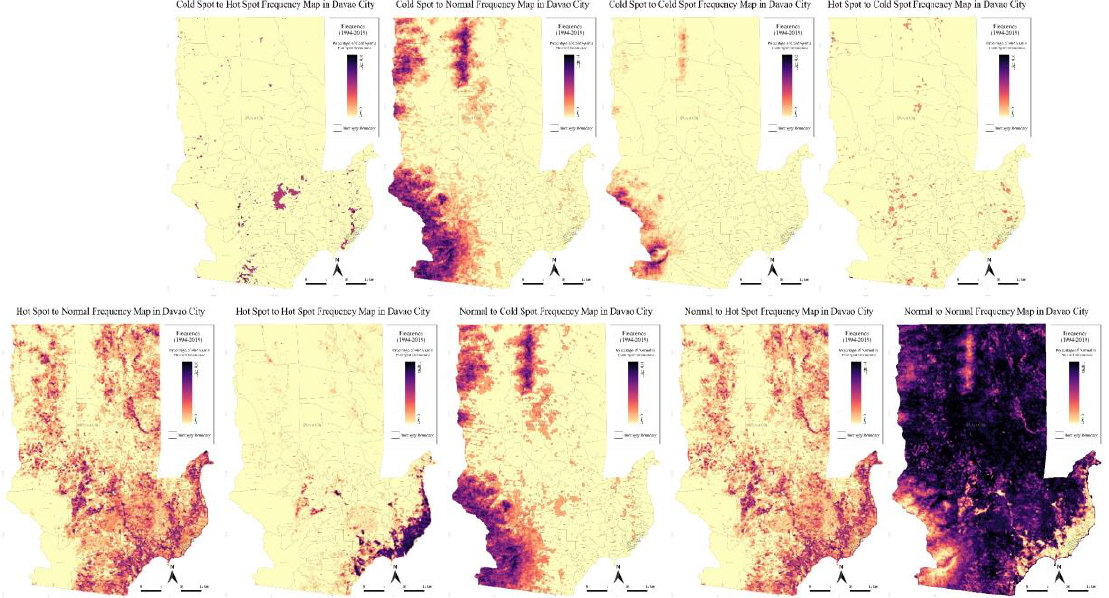
Figure 3. Frequency maps of transitions of cluster types. 1st row L-R: Cold to Hot, Cold to Normal, Cold to Cold, and Hot to Cold; 2nd row L-R: Hot to Normal, Hot to Hot, Normal to Cold, Normal to Hot, and Normal to